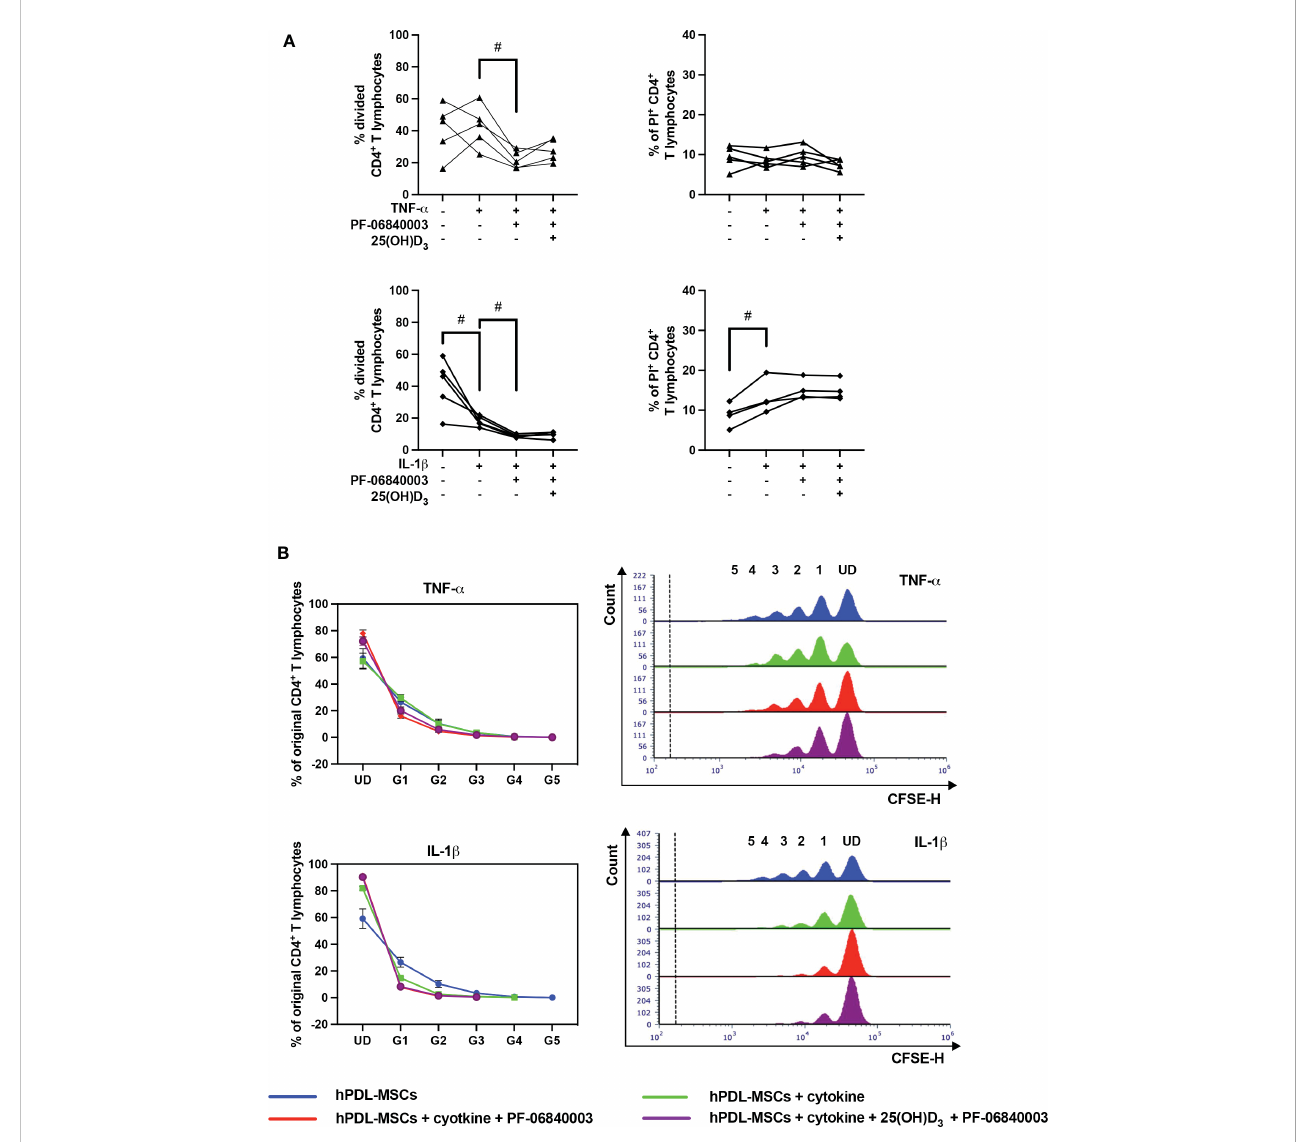
FIGURE 6 In fl uence of IDO-1 pharmacological inhibition on the CD4 + T lymphocyte proliferation and viability in the presence of hPDL-MSCs under different cytokine conditions. After fi ve days of indirect co-culture with hPDL-MSCs, fl ow cytometry analysis was used to determine the proliferation and viability of CD4 + T lymphocytes by CFSE and PI staining, respectively. (A) reveals the percentage of original CD4 + T lymphocytes that are divided and the percentage of PI + CD4 + T lymphocytes, whereas (B) shows the number of original CD4 + T lymphocytes as a percent of the total number of original cells for each single cell generation (UD = undivided; G1-G5 = generation 1 – generation 5). Additionally, representative histograms show the number of CD4 + T lymphocytes for all generations (UD and 1-5). Data were obtained from fi ve (A, B) or four (A) experimental repetitions using hPDL-MSCs from a different individual per repetition. One technical replicate was used per experimental group. In (A) , each experimental repetition is represented as an individual line. The percentage of original CD4 + T lymphocytes in (B) are presented as mean ± S.E.M. The Friedman test, followed by the Wilcoxon test, was used for pairwise comparison (A) . Viability data of CD4 + T lymphocytes, which were co-cultured with IL-1 b -treated hPDL-MSCs, were analyzed using one-way ANOVA and Tukey ’ s multiple comparison test. # p-value < 0.05 were considered to be statistically signi fi cant between groups as